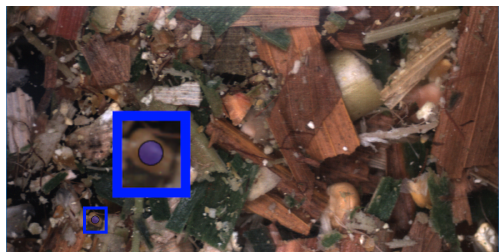
Figure 3. A blue indicator is shown, indicating the minimum size of particles to be